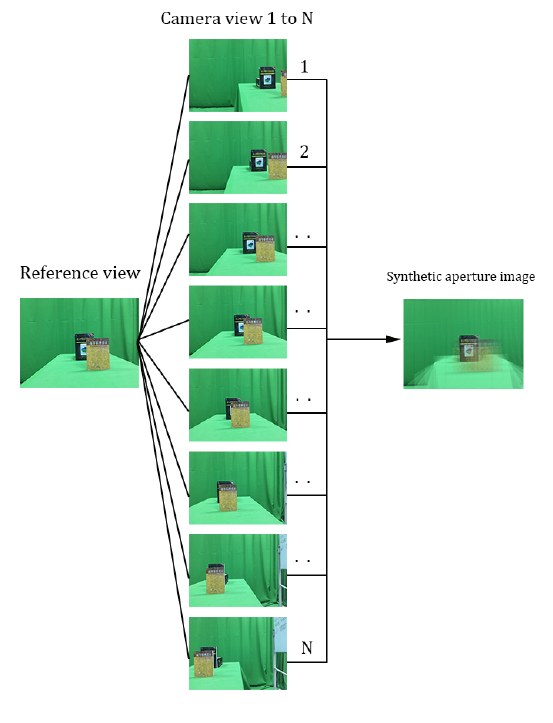
Figure 1. Synthetic aperture imaging.